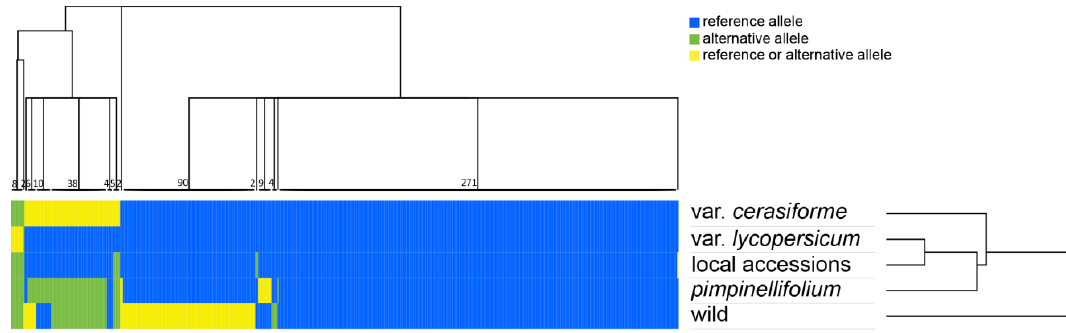
Figure 2. Hierarchical clustered heatmap representing color-coded SNP alleles as scored across 5 different groups of genotypes, i.e., var. cerasiforme ; var. lycopersicum ; local accessions; pimpinellifolium ; wild species (including S. habrochaites , S. cheesmaniae , and S. galapagense ). Numbers at the base of the tree indicate the SNP(s) that fall into each group. Blue: reference allele; green: alternative allele; yellow: reference or alternative allele.